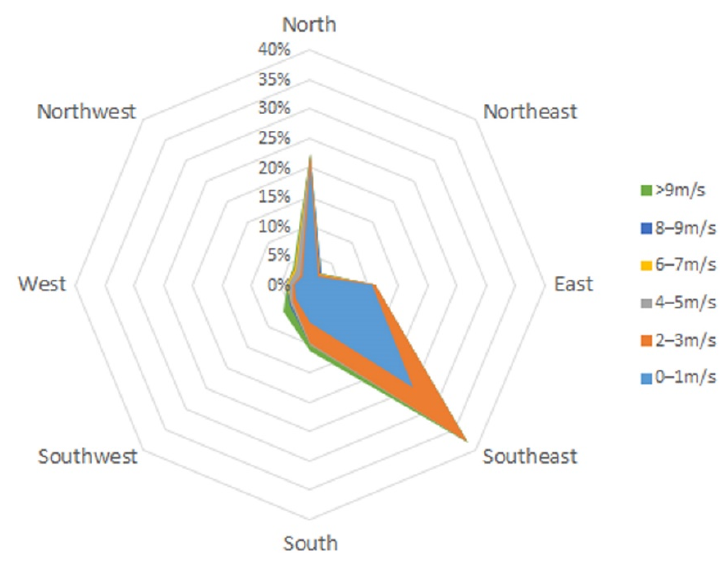
Figure 13. Wind environment for pattern type 4.